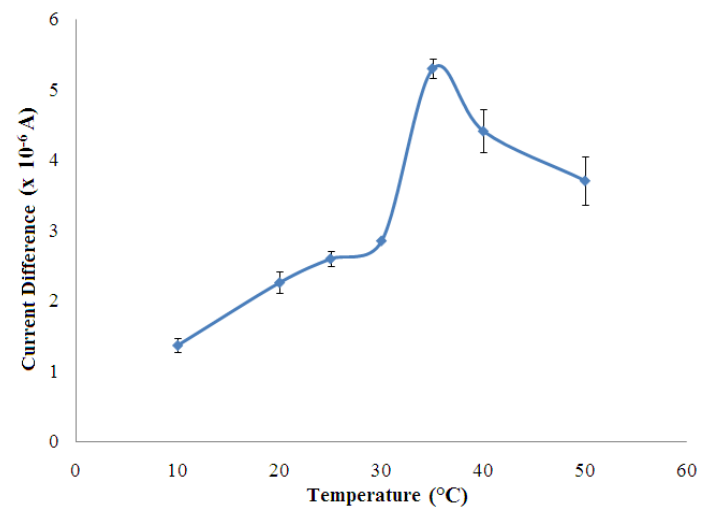
Figure 7. The temperature effect on the response of the NH 4+ ion biosensor in a solution containing 100 mM NH 4+ ion at pH 7 (n = 3). The biosensors were prepared one day before and stored at 4 °C before testing at various